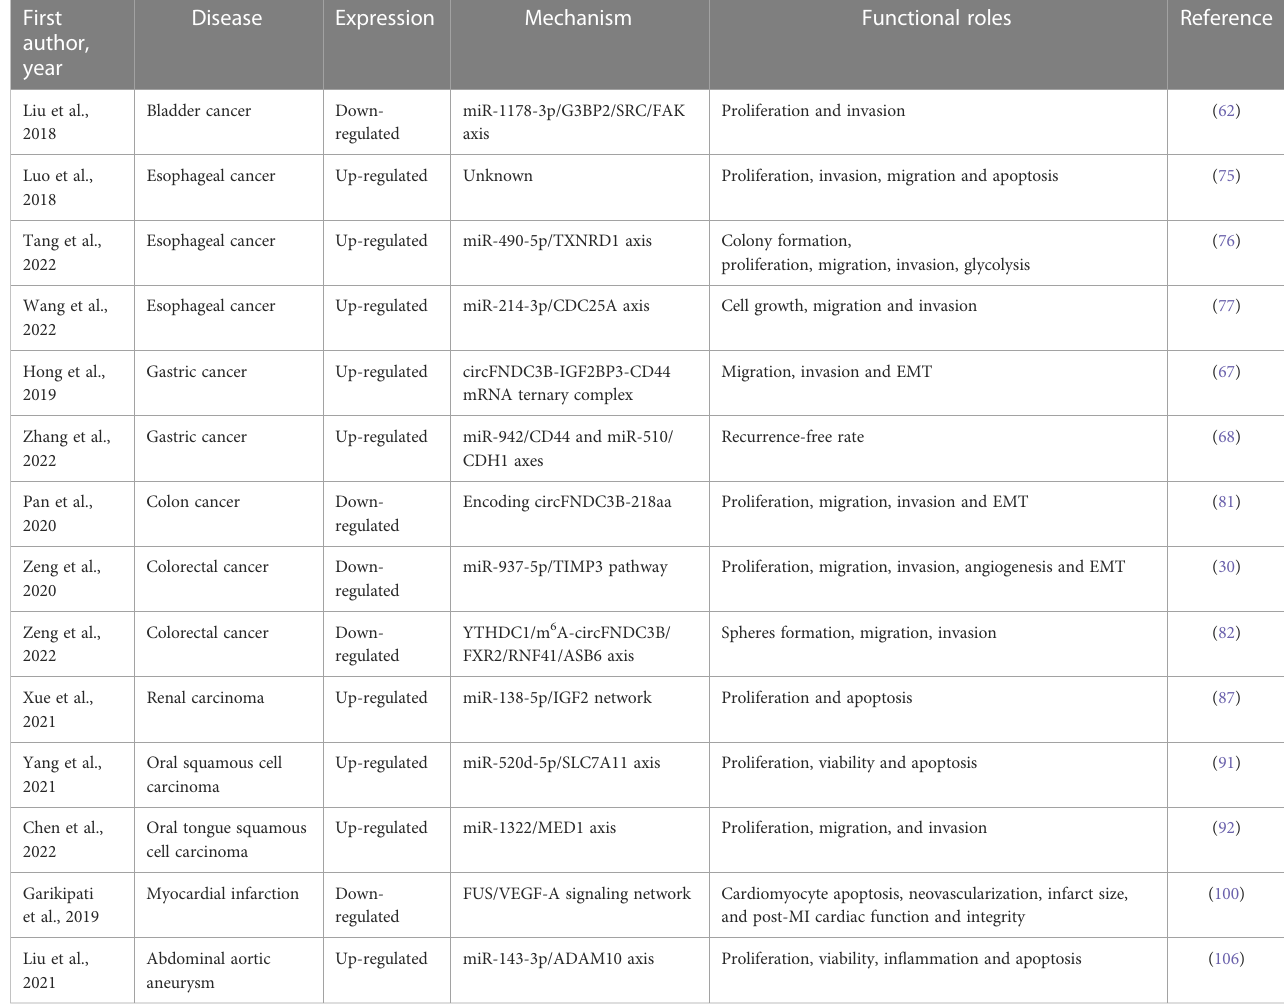
TABLE 1 Functional roles of circFNDC3B in different cancers and other